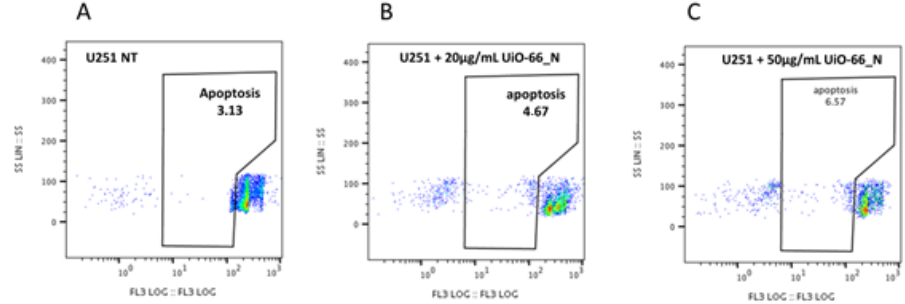
Figure 7. UiO-66_N administration does not induce apoptosis in U251 cells. Flow cytometry analysis of not treated ( A ) or treated U251 cells with 20 ( B ) or 50 ( C ) µ g/mL UiO-66_N for 48 h. Numbers inside the gates represent percentage of apoptotic U251 cells assessed by propidium iodide staining.